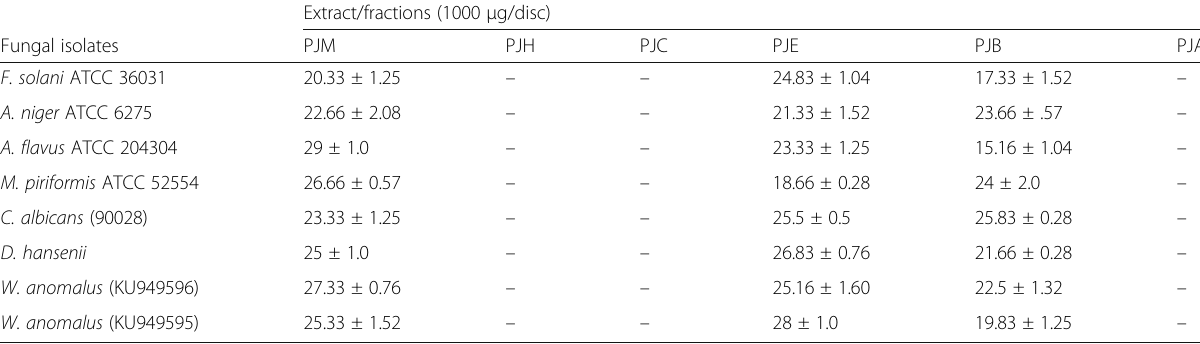
Table 7 Antifungal screening of P. jacquemontiana